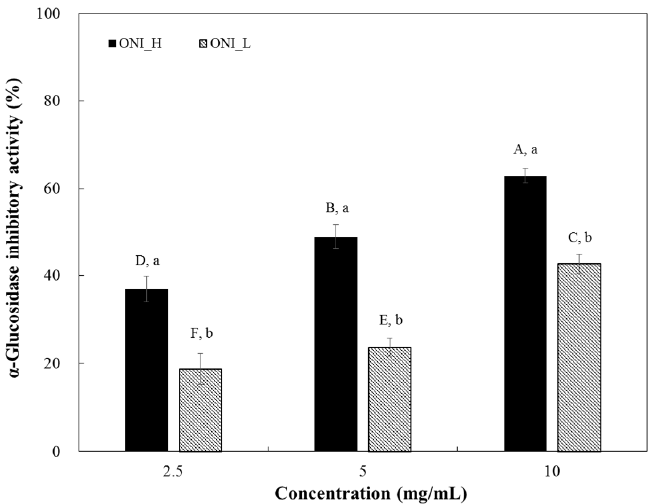
Figure 2. Dose dependent changes in rat small intestinal α -glucosidase inhibitory activities (% inhibition) of two different onion extracts (ONI_H and ONI_L). The results were expressed as mean ± S.D. with three independent experiments in triplicate. Different corresponding letters indicate significant differences at p < 0.05 by Duncan’s test. A–F The first letters in uppercase indicate significant differences among all samples and a–b the second letters in lowercase are different between ONI_H and ONI_L within the same concentration.